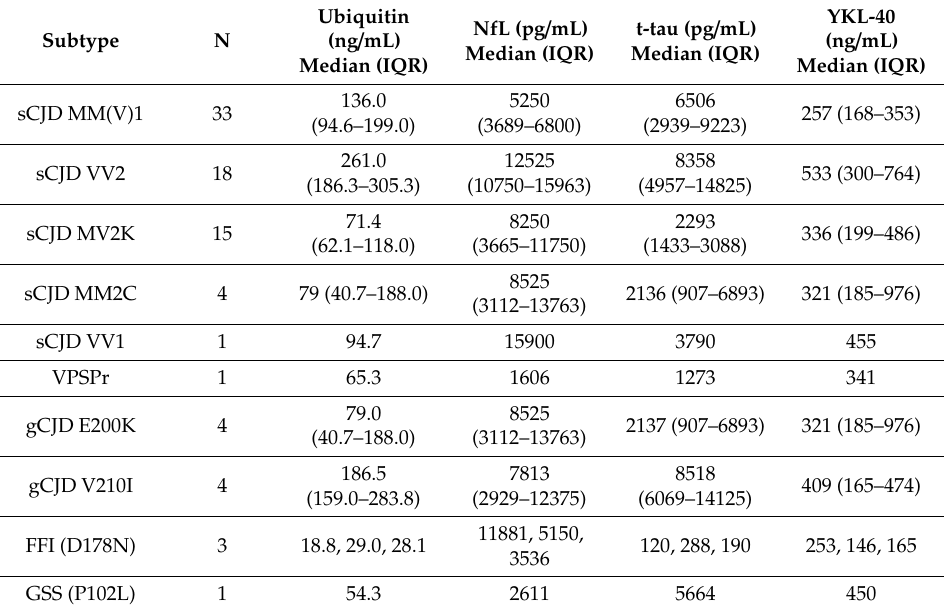
Table 3. CSF biomarkers in prion disease